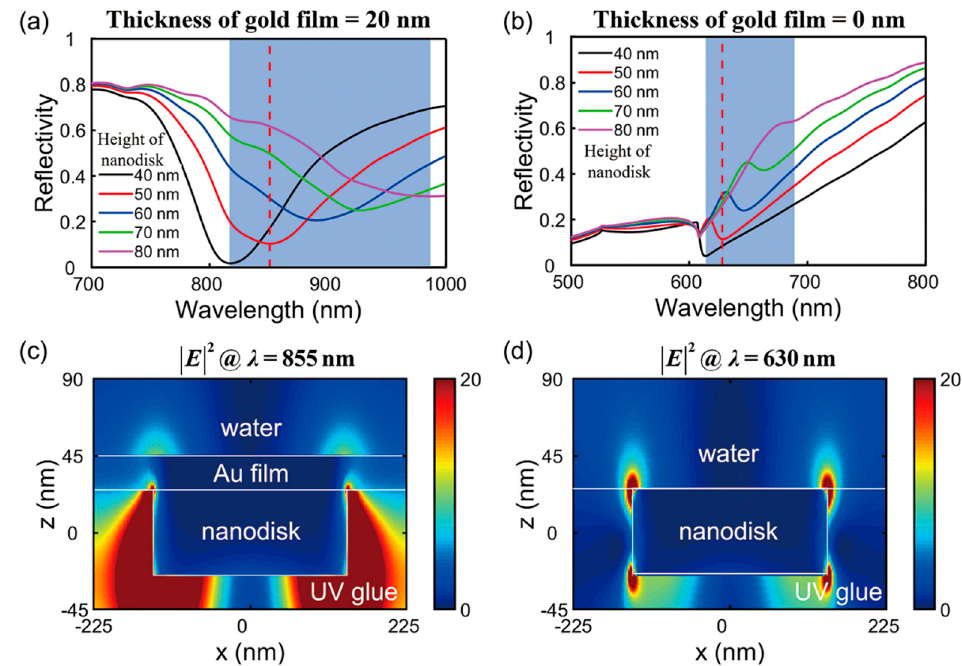
Figure 3. Simulated reflection spectra with various heights of Au nanodisk array for two comparative nanostructures: ( a ) Au nanodisk array/thin film coupled structure and ( b ) only the Au nanodisk array. The spatial distributions of the electric field in the x − z plane for plasmonic resonant dips of ( c ) Au nanodisk array/thin-film coupled structure and ( d ) Au nanodisk array. The wavelength positions of resonant dip corresponding to electric filed distributions in ( c , d ) are marked by vertical red dashed lines in ( a , b ).